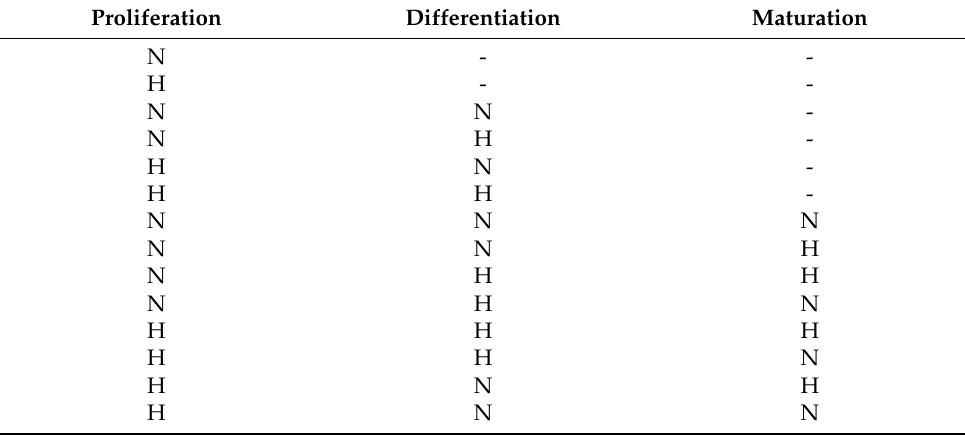
Table 2. Glycemic conditions at each step of cell culture for tested variants of